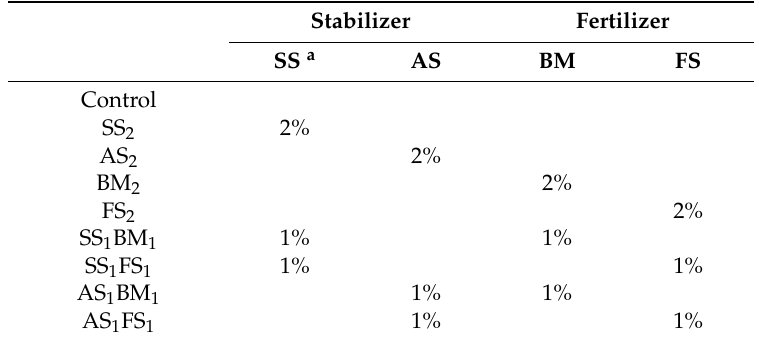
Table 1. Experimental setup with various combinations of immobilizers and fertilizers. Stabilizer